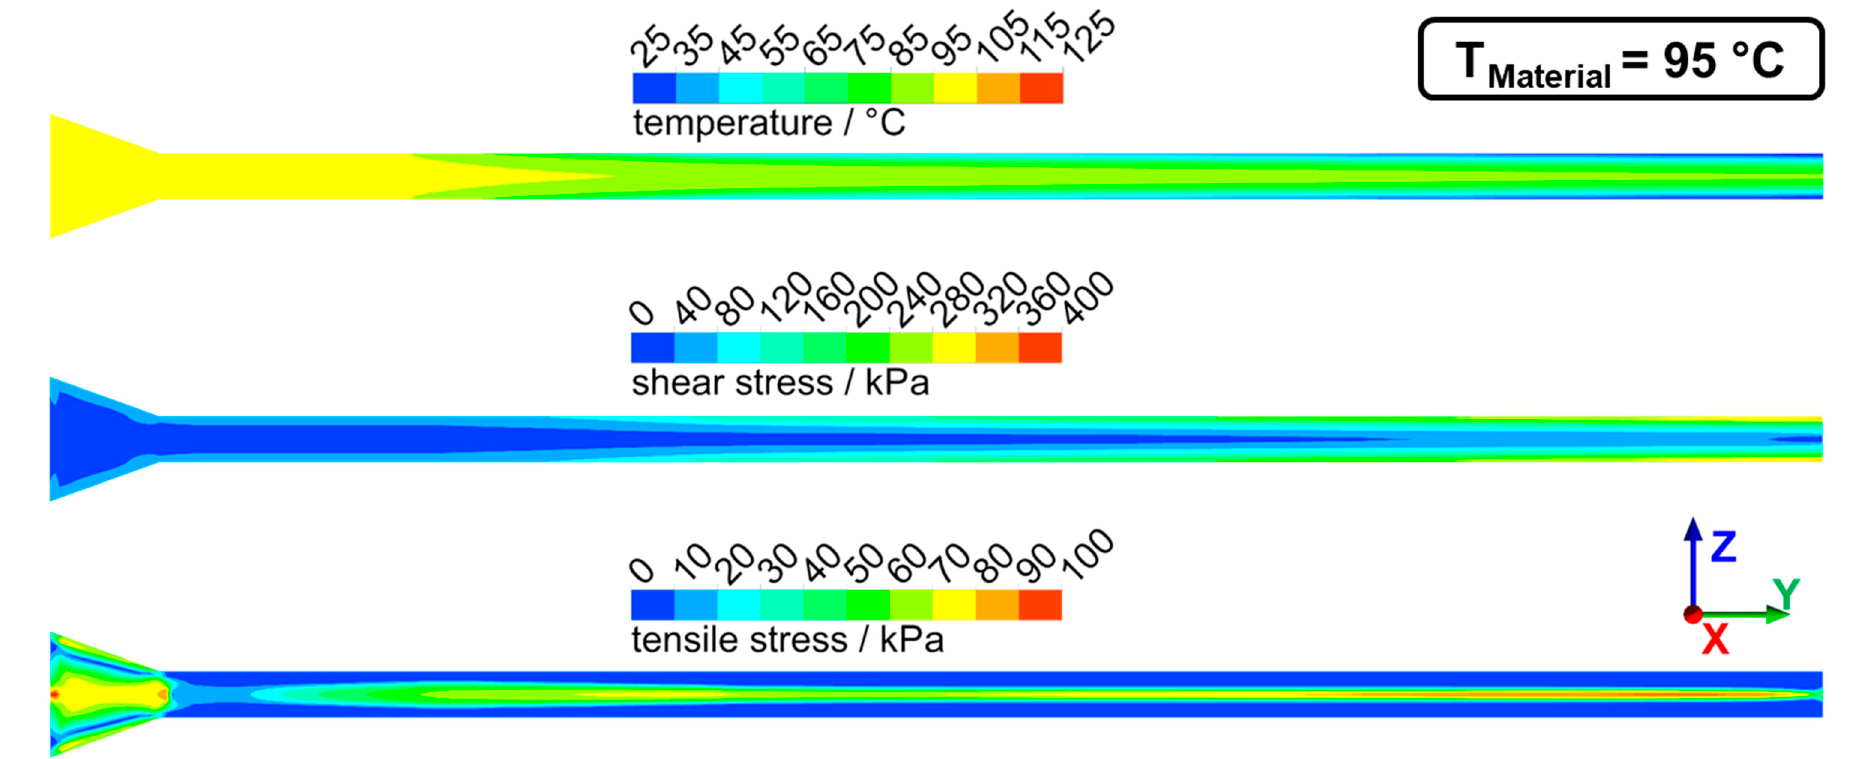
Figure 8. Temperature, shear stress, and tensile stress distribution in the die section of extrusion trials with T Material = 95 °C. The lateral view is displayed, flow direction from left to right (in the y-direction).